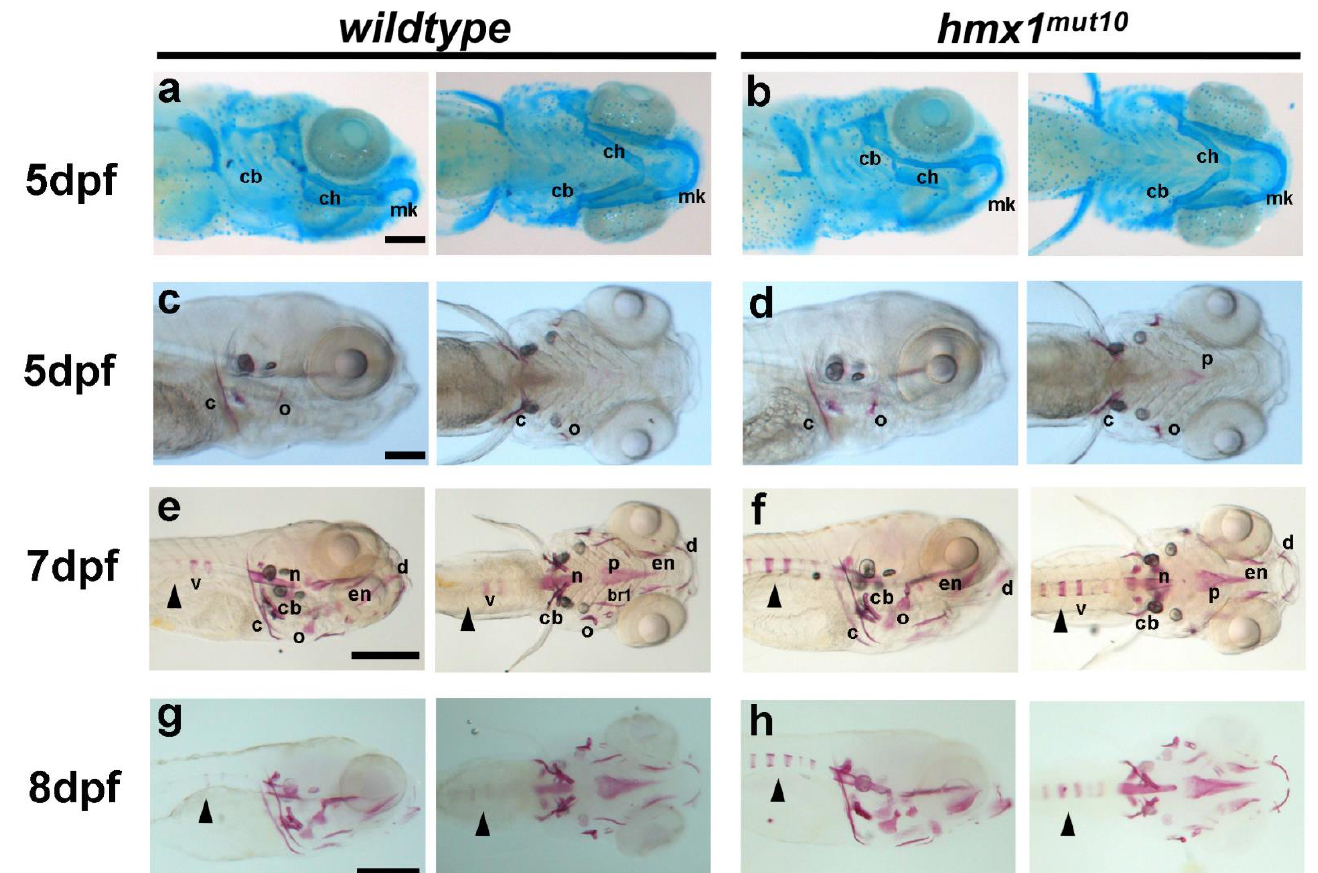
Figure 1. Hmx1 mut10 zebrafish embryos develop early mineralized vertebrae: Cartilage structures stained with alcian blue in wildtype and hmx1 mut10 embryos ( a , b ) at 5 dpf; no morphological differ- ences in the developing cranial cartilage structures were detected. Cranial bone structures stained with alizarin red in wildtype and hmx1 mut150 at 5 dpf ( c , d ); wildtype and hmx1 mut10 present regular development of bone structures. At 7 dpf and 8 dpf, alizarin red staining detected an early and progressive mineralization of the vertebrae in hmx1 mut10 ( f , h ) in comparison to wildtype zebrafish ( e , g ). cb, ceratobranchial pairs; ch, ceratohyal; mk, Meckel’s cartilage; v, vertebrae; c, cleithrum; n, notochord; cb, ceratobranchial 5; en, entopterygoid; o, opercle; d, dentary. Black arrowhead: early